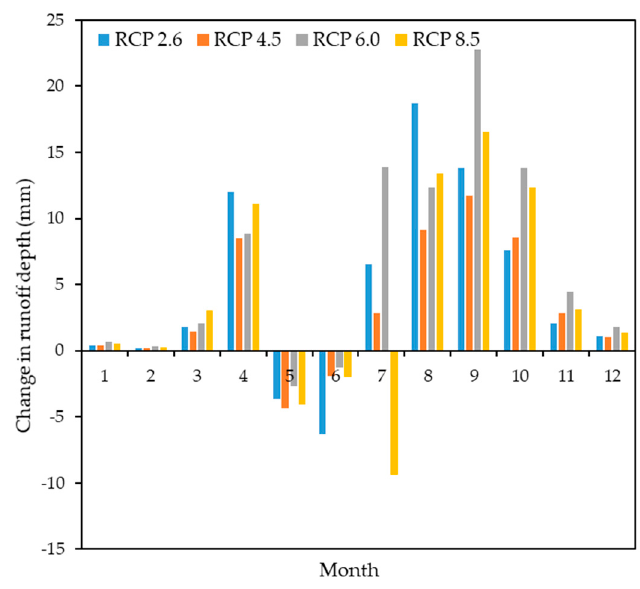
Figure 7. Monthly runoff depth changes for the 2050s under RCP 2.6, RCP 4.5, RCP 6.0 and RCP 8.5 emission scenarios compared with the base years (2006–2016).